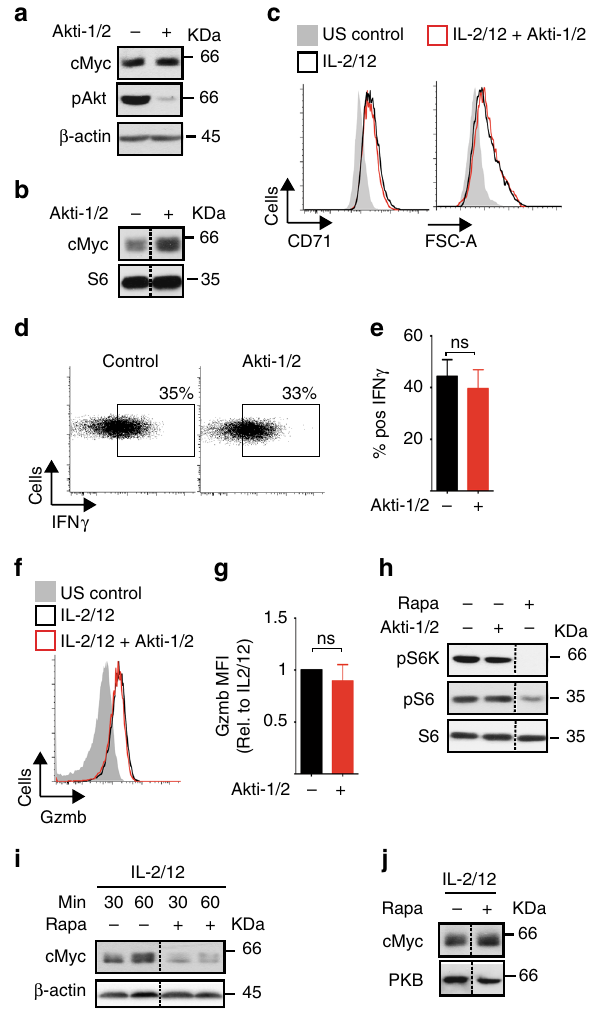
Fig. 3 mTORC1, but not Akt, is required for cMyc expression in IL-2/IL-12- stimulated NK cells. a NK cells were left unstimulated (US) or stimulated with IL-2/IL-12 for 18 h and Akti-1/2 (2 μ M) was added for the last 1 h of activation, before immunoblot analysis for levels of cMyc, phosphorylated Akt on serine 473 (pAkt) and β -actin. b NK cells were stimulated with IL-2/ IL-12 in the presence or absence of Akti-1/2 (2 μ M) for 18 h before immunoblot analysis of cMyc and S6 ribosomal protein (S6, loading control) levels. c – g NK cells were left unstimulated or stimulated with IL-2/ IL-12 in the presence or absence of Akti-1/2 (2 μ M) for 18 h, then analysed by fl ow cytometry for FSC-A and CD71 expression ( c ), IFN γ production ( d , e ) and granzyme B expression ( f , g ). h NK cells were left unstimulated or stimulated with IL-2/IL-12 for 18 h and Akti-1/2 (2 μ M) or rapamycin (20 nM) were added for the last hour of activation as indicated. Samples were subjected to immunoblot analysis for levels of phosphorylated S6 ribosomal protein on serine 235/6 (pS6), phosphorylated p70 S6 kinase on serine 389 (pS6K) and S6 ribosomal protein (S6). i , j NK cells were stimulated with IL-2/IL-12 for 30 min, 60 min ( i ) or 18 h ( j ) in the presence or absence of rapamycin (20 nM) as indicated before immunoblot analysis for cMyc and β -actin expression. Data are mean ± s.e.m of 6 experiments ( e , g ), or representative or 3 ( a – j ) or 6 ( c – f ) individual experiments.